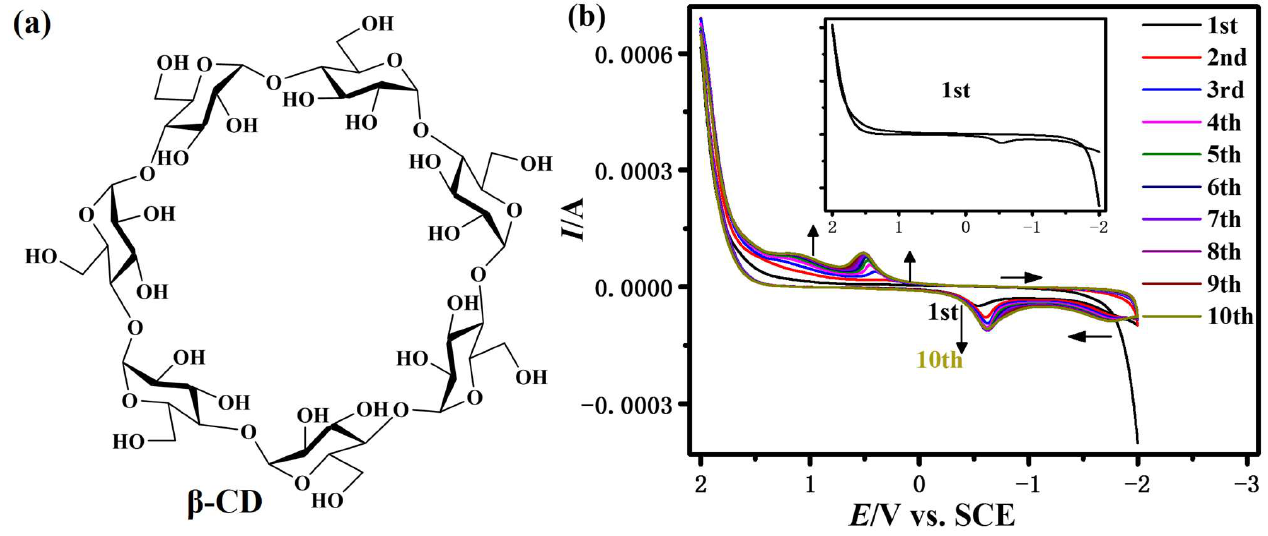
Figure 1. ( a ) The chemical structure of β-CD; ( b ) multicycle CV curves of β-CD (6 mM in phosphate buffer solution, pH = 6.80) on GCE with potential from −2.0 to 2.0 V, scan rate of 100 mV/s and 10 cycles. Inset: the first CV curve of β-CD on GCE.